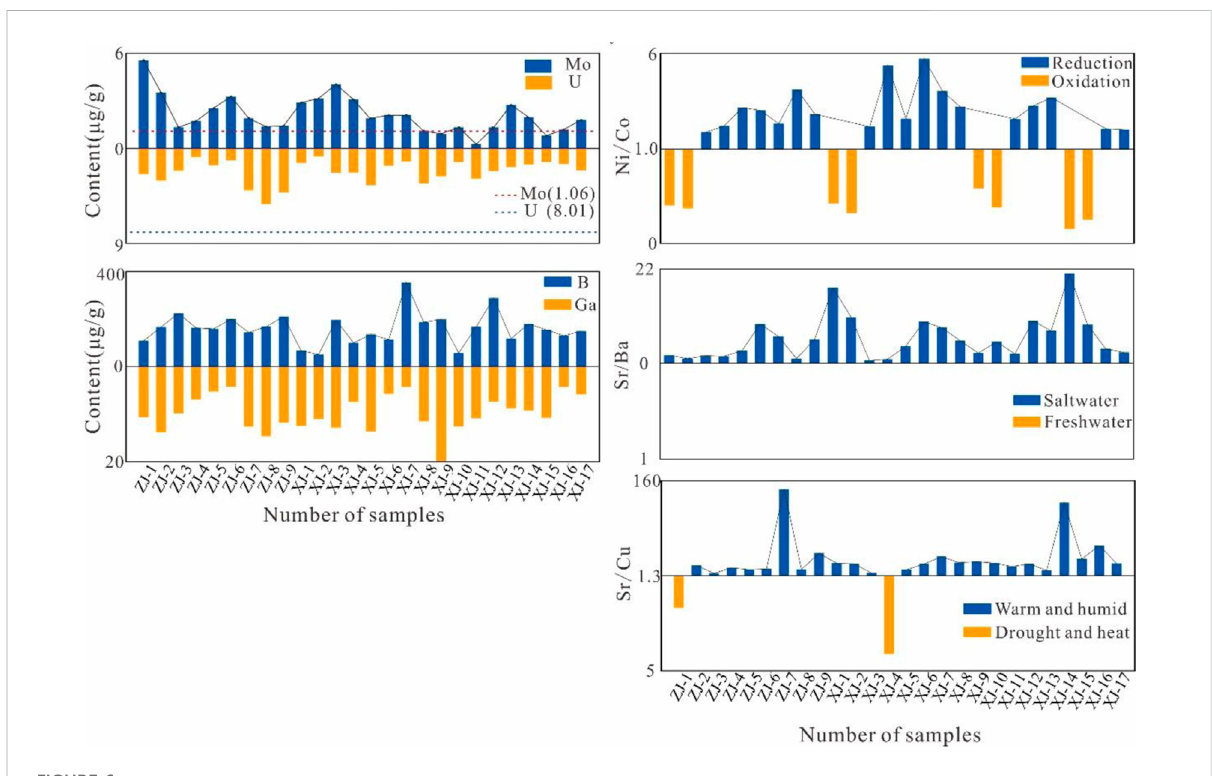
FIGURE 6 Characteristics of depositional